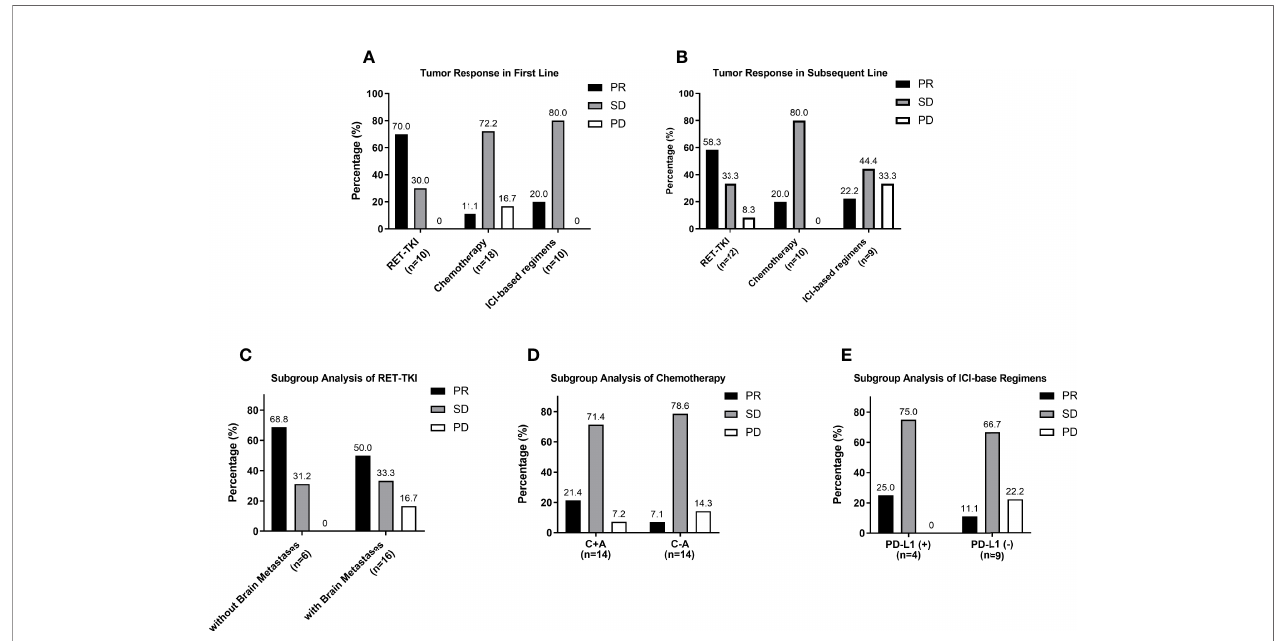
FIGURE 3 | Subgroup analysis of tumor response. (A) Analysis of tumor response of different regimens in fi rst-line treatment. (B) Analysis of tumor response of different regimens in subsequent-line treatment. (C) Analysis of tumor response in group of patients treated with RET-TKI with brain metastases or without. (D) Analysis of tumor response in group of patients treated with chemotherapy with or without angiogenesis inhibitor. (E) Analysis of tumor response in group of patients treated with ICI-based regimens with negative PD-L1 or positive PD-L1. PR, partial respons;. SD, stable disease; PD, progressive